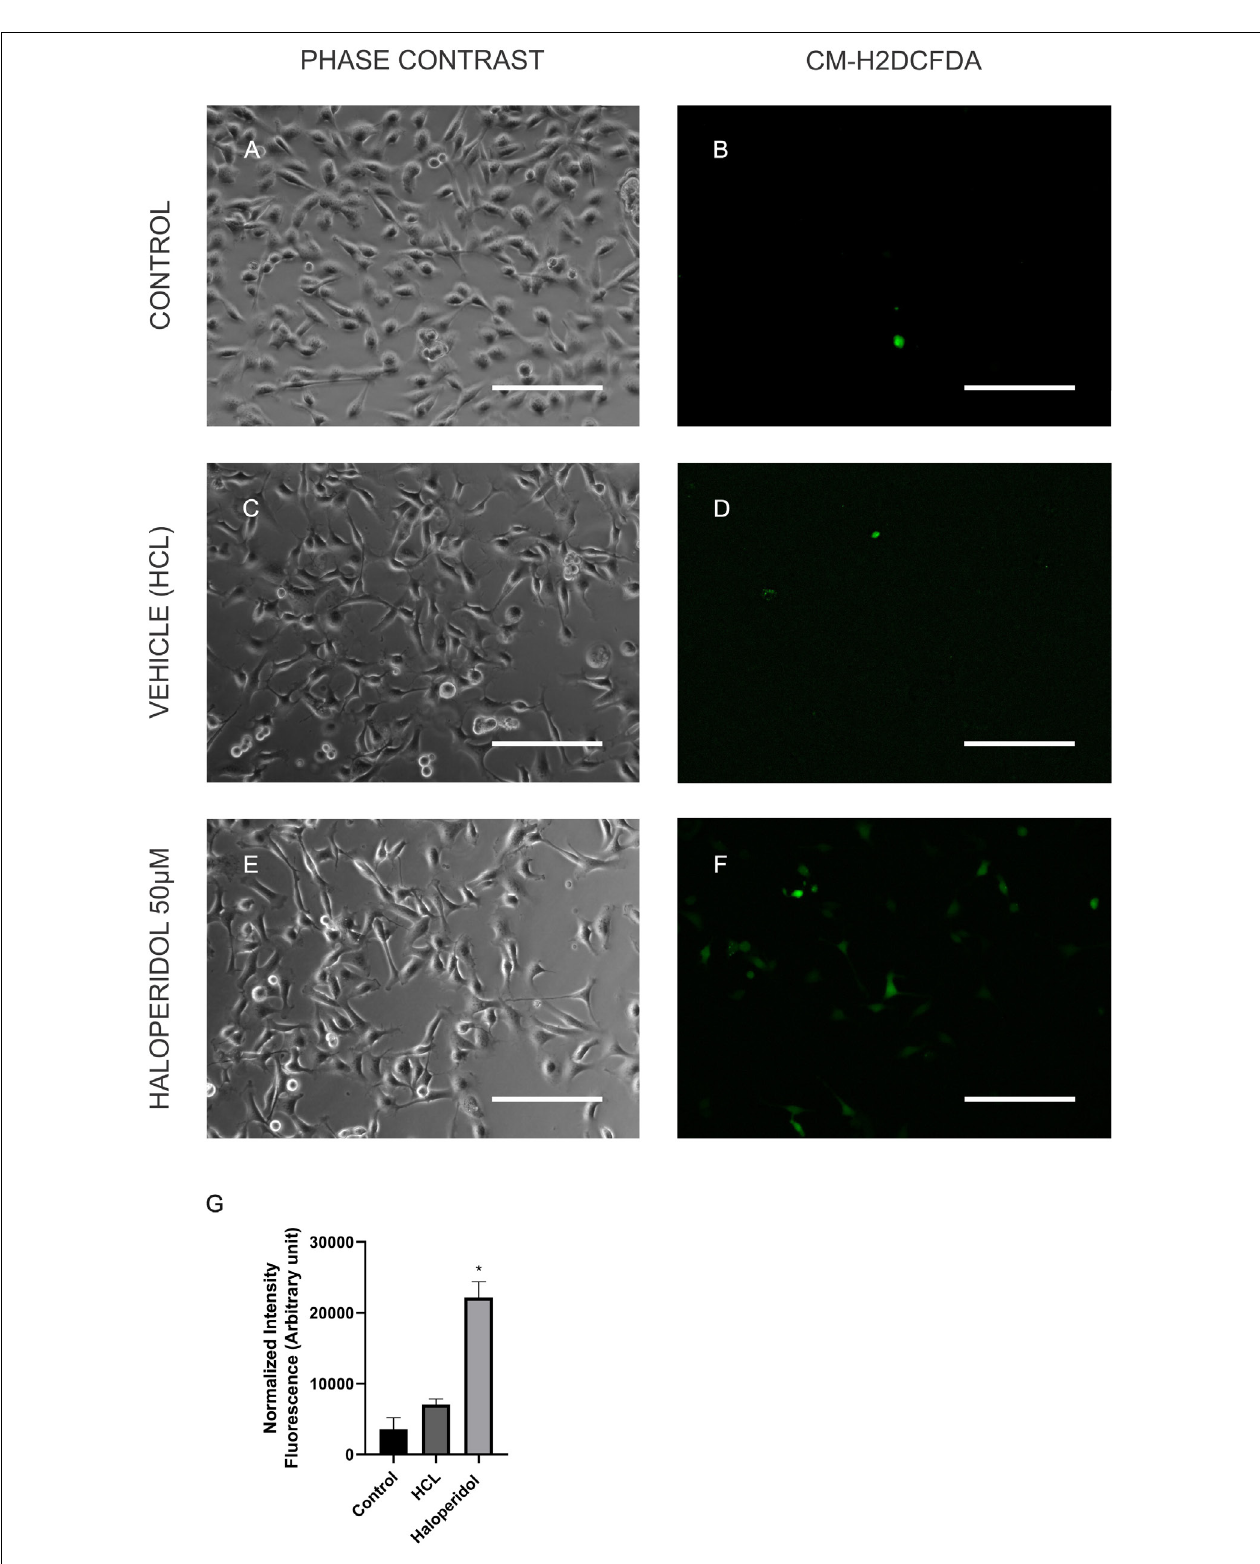
FIGURE 3 | MO3.13 after treatment with control (A,B) , vehicle (HCL; C,D ), and haloperidol 50 µ M (E,F) for 4 h, and incubation with CM-H2DCFDA. Fluorescence is shown here in false colors and green for CM-H2DCFDA. (G) Statistic chart showing normalized intensity fluorescence for CM-H2DCFDA for each treatment ( ∗ P < 0.05). Scale bars = 200 µ